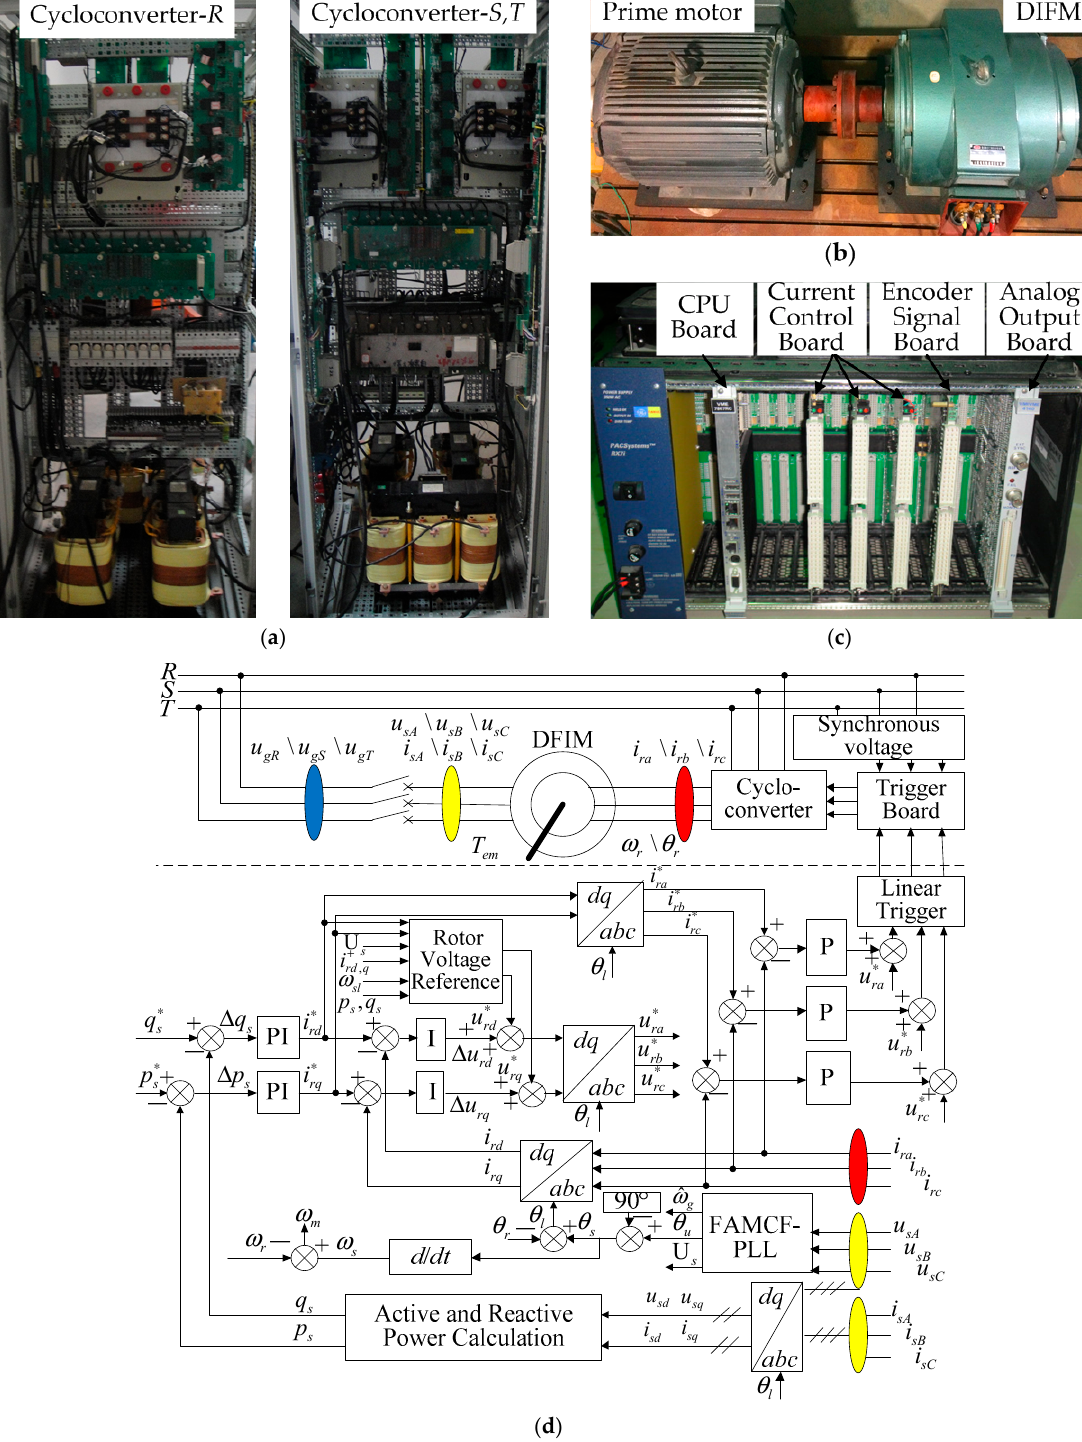
Figure 8. Images of the experimental platform. ( a ) Cycloconverter power cabinet; ( b ) DIFM and prime motor; ( c ) Control system; ( d ) Control diagram of the doubly-fed, adjustable-speed, pumped storage hydropower plant.